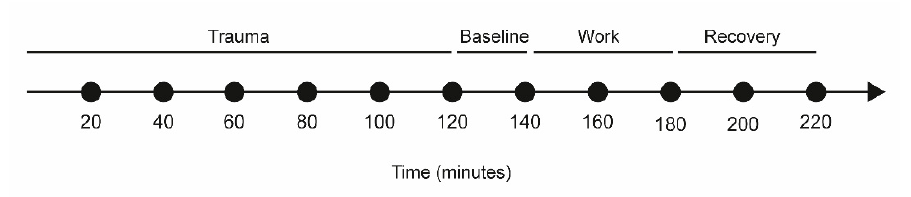
Figure 2. Timeline of microdialysis sampling. The time 0–120 min refer to tissue trauma, 120–140 min refer to baseline, 140–180 min is the working period and 180–220 is called the recovery period. During the MD session, subjects rated the pain intensity in trapezius muscle in right and left side, every 20 min using NRS. Samples were obtained every 20 min during the in total 220 min long MD test period and the samples were kept on ice throughout the MD experiment. The samples were then stored as aliquots in − 86 °C until analysis. Vials with visible sign of hemolysis were discarded. 2.9. Biochemical Analysis The dialysate samples from baseline, work period, and recovery were thawed, cen- trifuged, and analyzed for the concentrations of pyruvate, lactate, glutamate, glycerol, and glucose with ISCUSflex Analyzer (CMA Microdialysis AB, standard range, Solna, Swe- den). The detection intervals are as follows: 0.1–12 mmol/L for lactate; 10–1500 μ mol/L for pyruvate; 1.0–150 μ mol/L for glutamate; 0.1–25 mmol/L for glucose; and 10–1500 mmol/L for glycerol. For measuring the concentration of inflammatory proteins, a commercially available 71-panel of cytokines/chemokines (No. K15081K-1) from MesoScale Discovery (Meso Scale Diagnostics, Rockville, MD, USA) was used according to the manufacturer’s instruc- tions. 2.10. Statistics For analysis of demographic data, the median value (min-max) was calculated. Wil- coxon paired test was used to compare results before and after the intervention. These statistics were performed using the statistical package IBM SPSS Statistics (version 24.0; IBM Corporation, Route 100 Somers, New York, NY, USA). A probability of <0.05 (two- tailed) was accepted as the criteria for significance. To investigate the multivariate corre- lation and between membership of groups and quantified proteins and metabolites or- thogonal partial least square discriminant analysis (OPLS-DA) was used (SIMCA-P+ ver- sion 13.0, UMETRICS, Umeå, Sweden). Before this analysis, principal component analysis (PCA) was used to check for multivariate outliers. The procedure to compute multivariate correlation models has been described earlier [41] and is in accordance with [42]. 3. Results The demographic data is presented in Table 1. Data from one subject was excluded from the analysis due to defect of the DynaDesk. The moveable part of the desk was un- stable, and the subject decided to not use the movable function of the desk. The dialysate samples from each 20-min sampling were analyzed for the metabolites (pyruvate, lactate, glucose, glycerol, and glutamate). In total 198 samples at static computer work (SCW) and DCW were analyzed. For protein analysis pooled samples from different timepoints were used due to low recovery of proteins. The samples from each subject were pooled indi- vidually as: timepoint 0–100 (trauma), 120–140 (baseline), 160–180 (working), and 200–220 (recovery) (Figure 2). In total 72 samples were analyzed. 3.1. Self-Reported Markers There was significant reduction ( p < 0.05) in pain in the neck after 4-weeks DCW (Fig- ure 3). As illustrated in Figure 3, subjects reported significantly lower HADS after 4-weeks